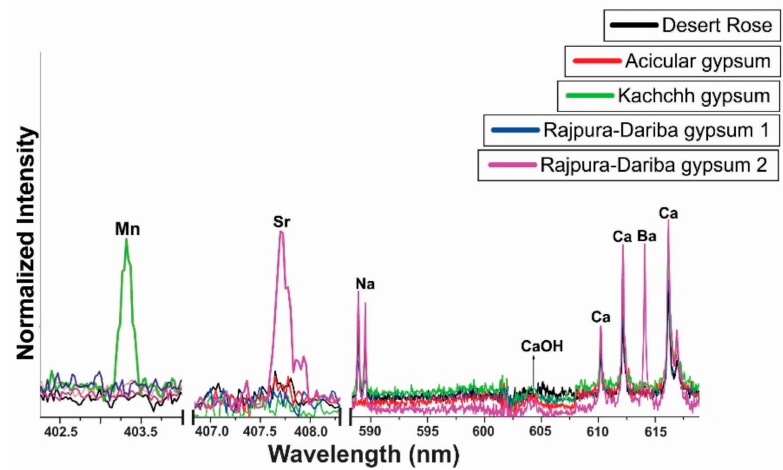
Figure 6. Spectral regions of recorded Mn, Sr, Ca, and Ba atomic and CaOH molecular data for the gypsum samples.